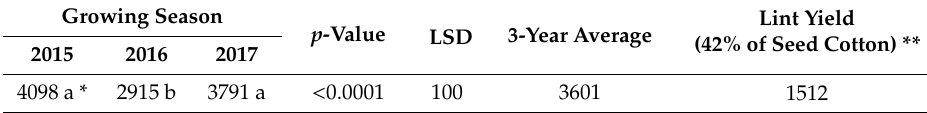
Table 5. Seed cotton yield (kg ha − 1 ) from 2015, 2016, and 2017 growing seasons.